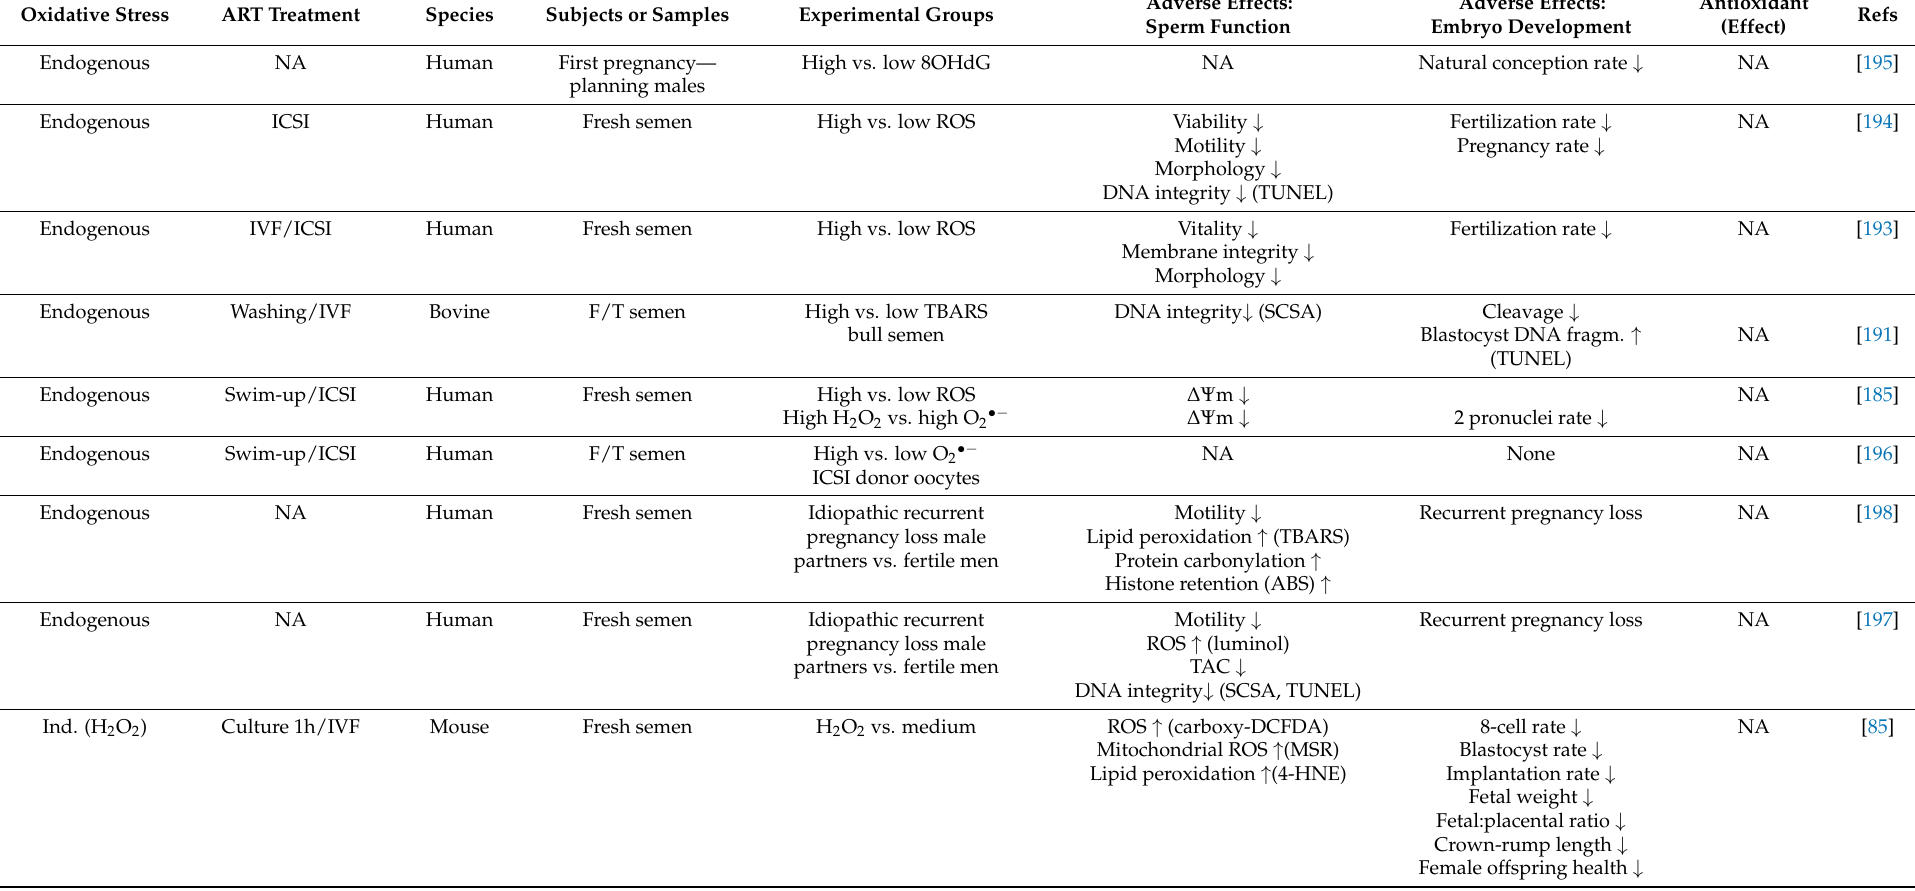
Table 1. Effects of endogenous, experimentally induced, and art-associated oxidative stress on sperm function, embryo development, and reproductive